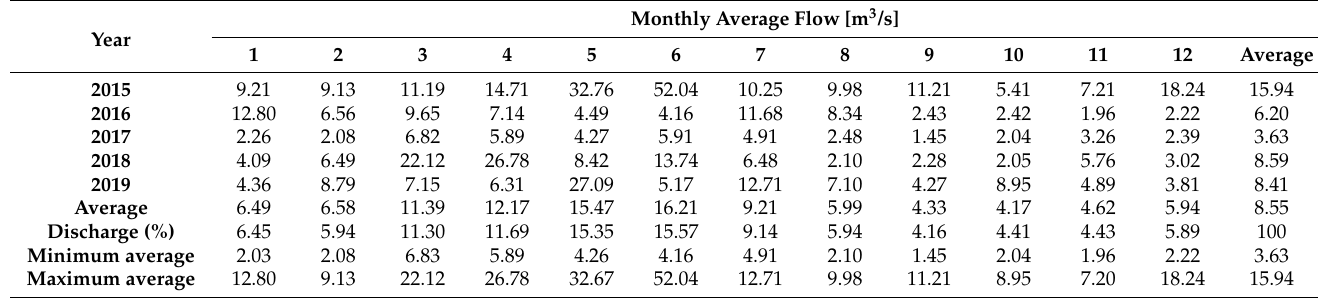
Table 4. Average flow rates of the Torysa river in the Kosicke Olsany hydrological station (8870). Year